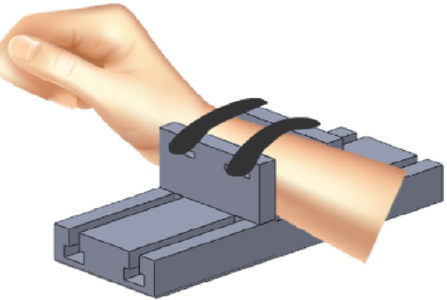
Figure 1. The arm fixation apparatus. The distance between the walls was adjusted according to the width of the forearm and secured using two Velcro